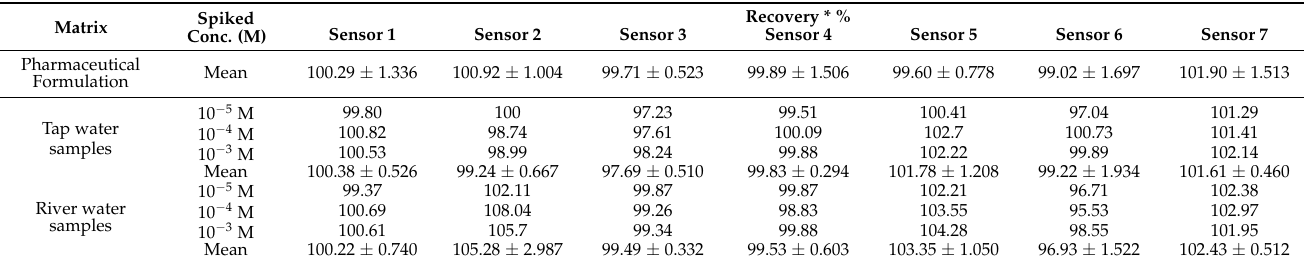
Table 4. Potentiometric determination of gemifloxacin in pharmaceutical formulation, spiked tap water and spiked river water samples using the proposed sensors.